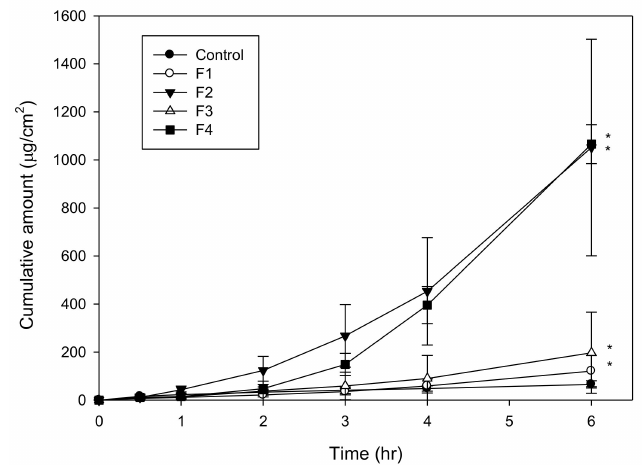
Figure 2. In vitro penetration time profiles of gemcitabine-loaded formulations and control drug solution (* p <